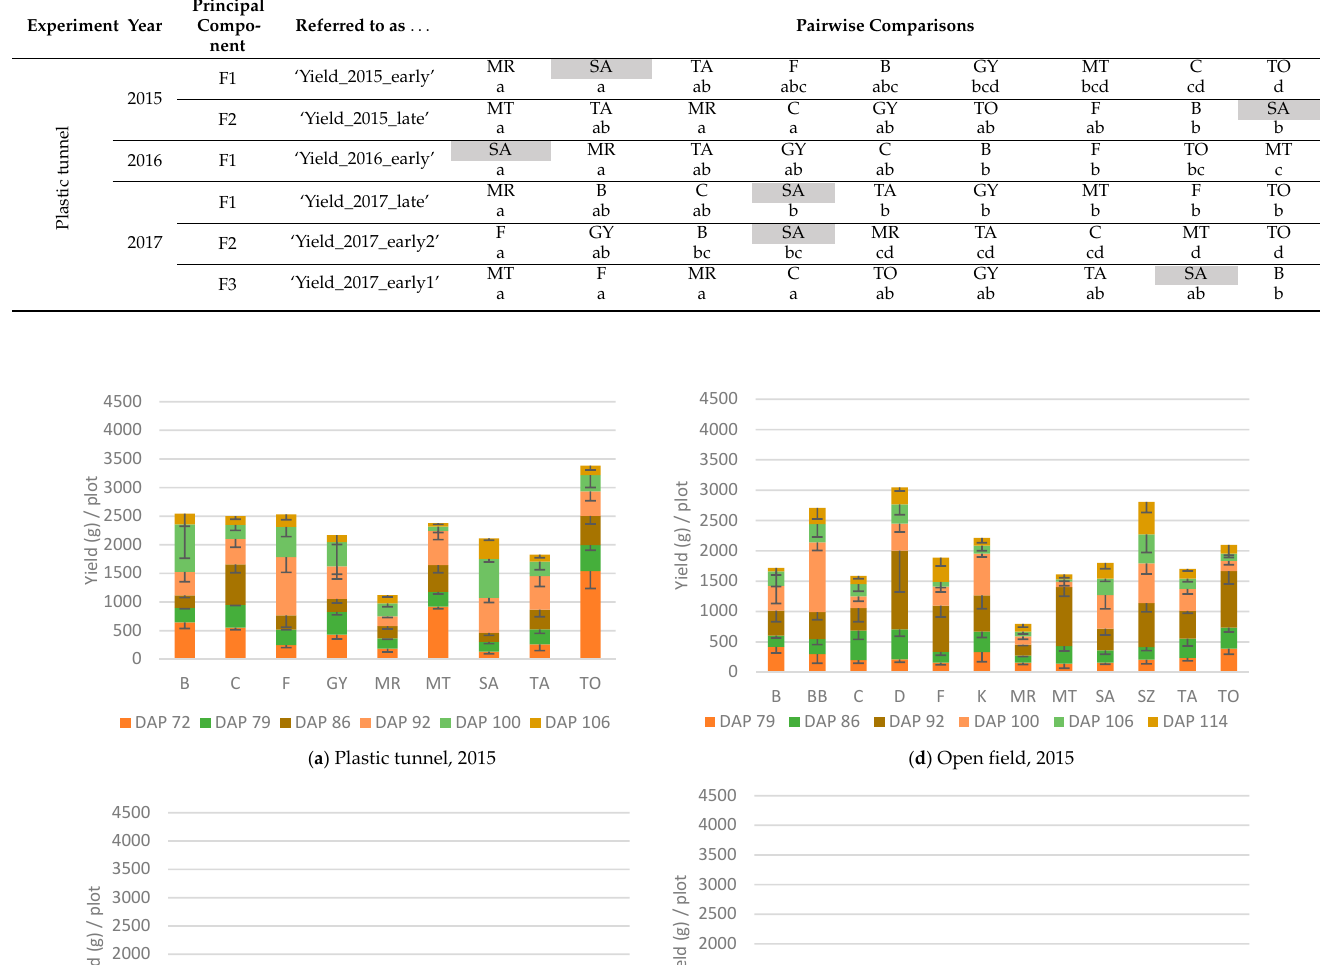
Table 7. The post hoc test results of the significant PCs obtained from the yield data of the different tomato gene bank items and control varieties regarding the open-field experiment. Different letters from lower to higher yields represent significantly different groups (Games-Howell’s, p < 0.05). Abbreviations of the Hungarian gene bank items are: B: ‘Bala- tonboglár’; C: ‘Cegléd’; F: ‘Fadd’; GY: ‘Gyöngyös’; MR: ‘Máriapócs’; MT: ‘Mátrafüred’; TA: ‘Tarnaméra’; TO: ‘Tolna megye’. The control variety is SA: ‘San Marzano’. Determinate gene bank items: BB: ‘Balatonboglár’; D: ‘Dány’; SZ: Control accessions are highlighted with grey background color. Referred to as ... nent